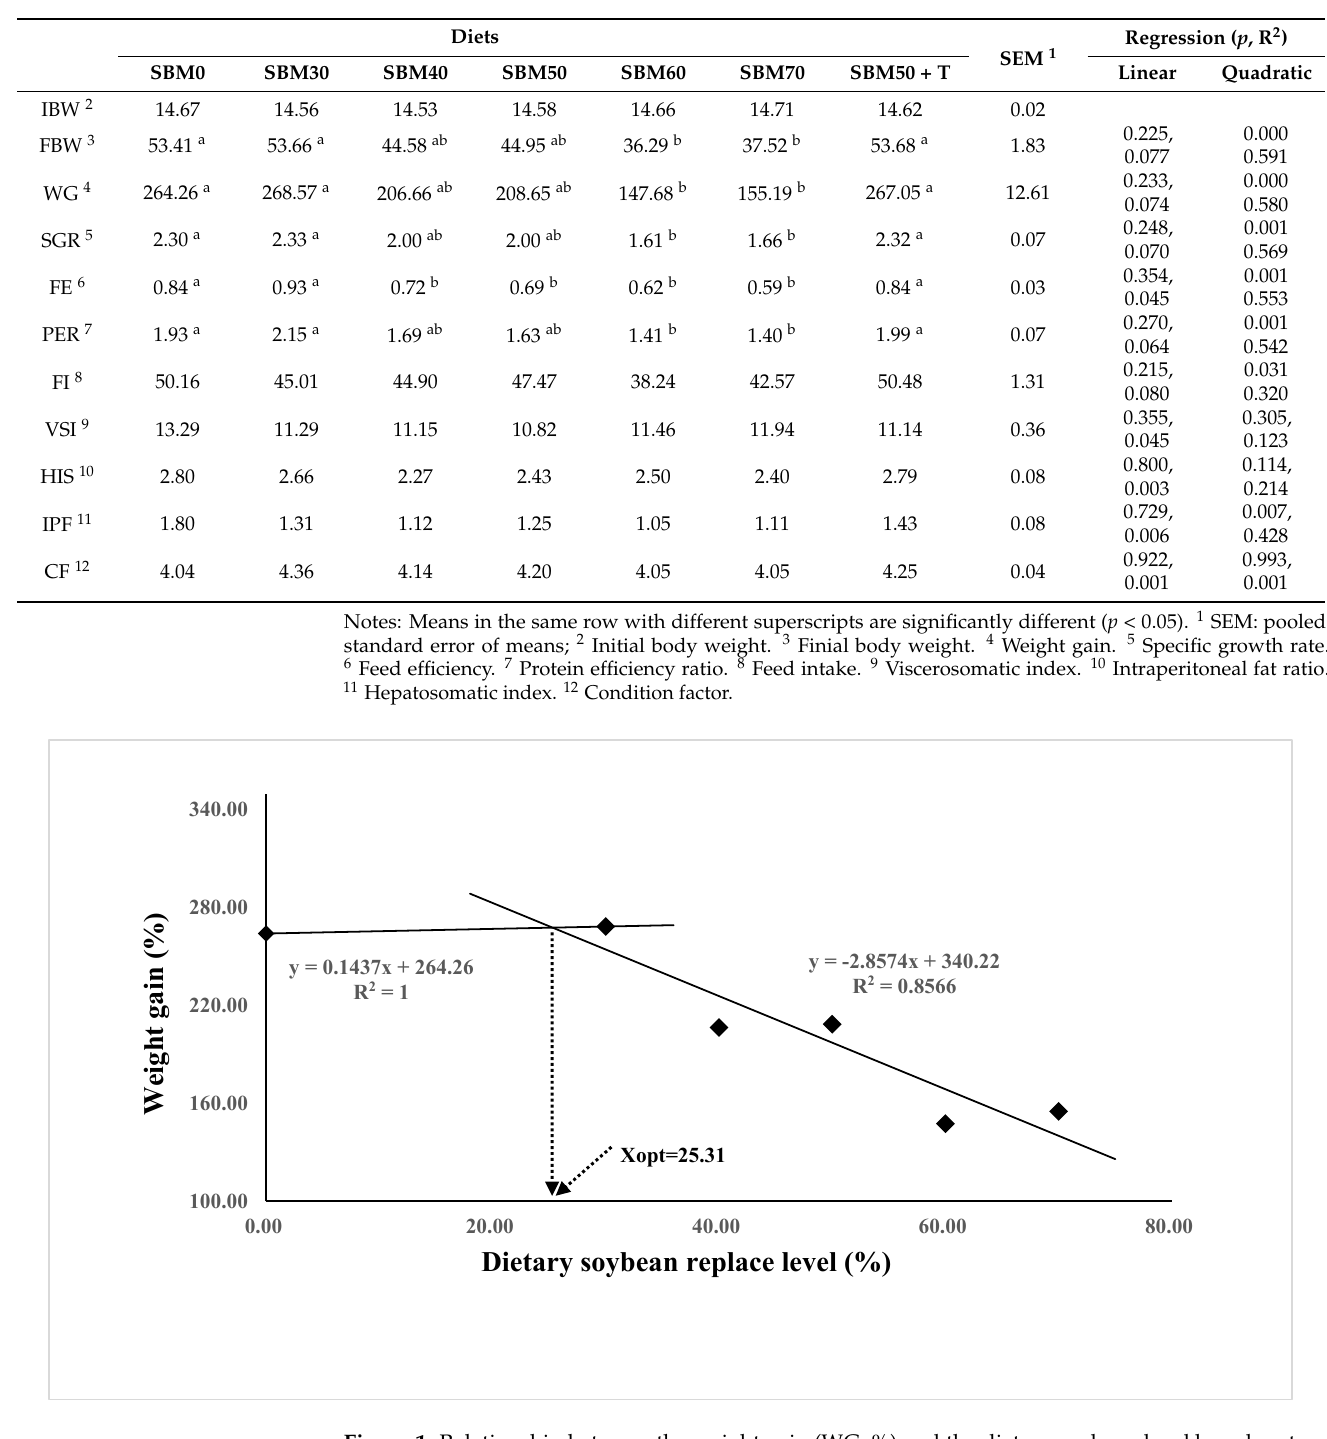
Table 4. Growth, feed utilization, and morphometrical parameters of juvenile Oplegnathus punctatus fed diets containing different levels of soybean meal.